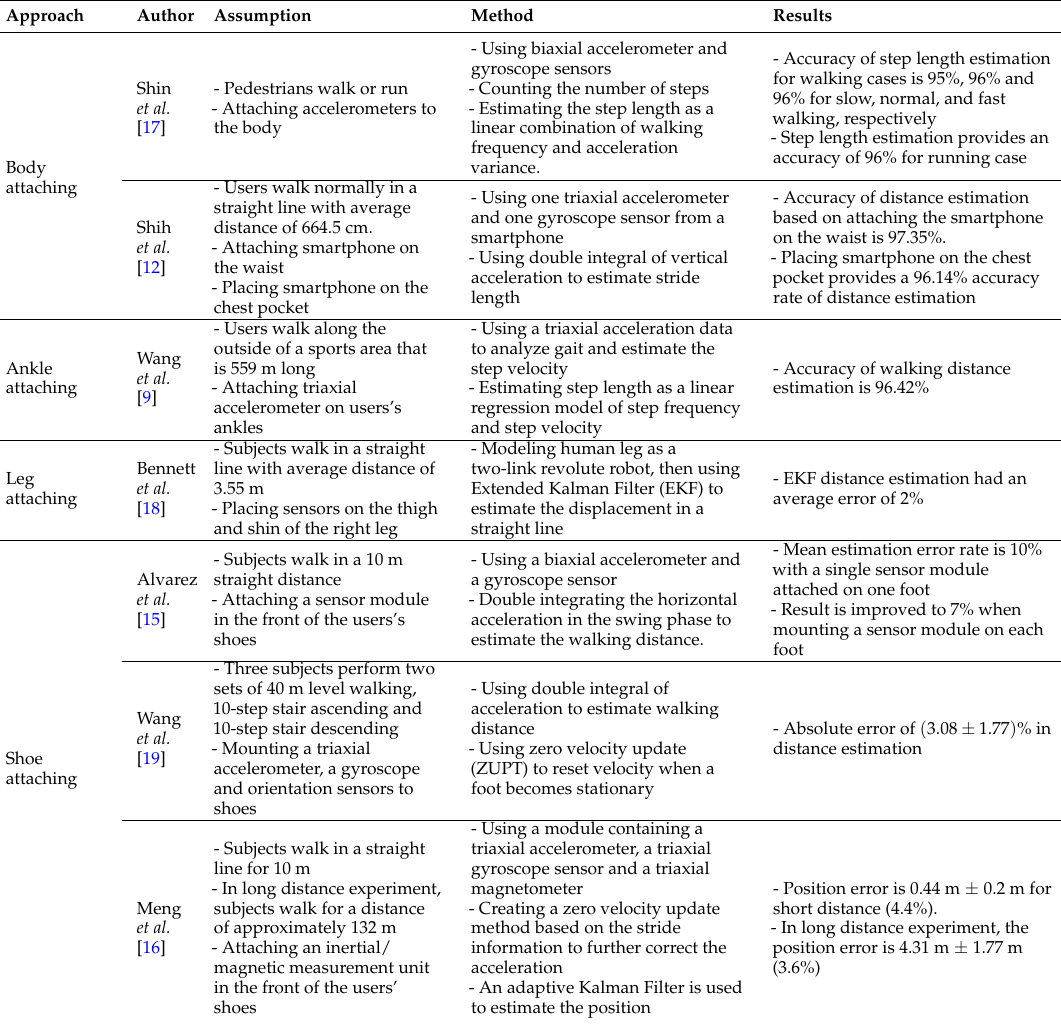
Table 1. Comparison of walking distance estimation